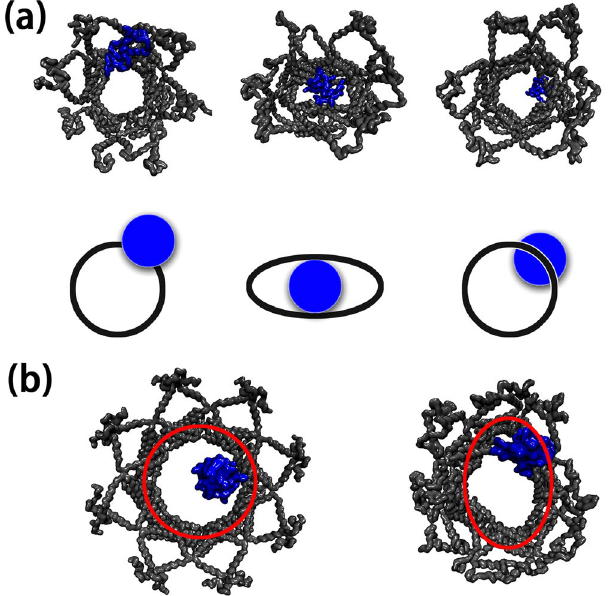
Figure 6. Snapshots for the simulated six-dimer Bax pores at ① (top left), ① (top middle) and ① (top right), and the schematic diagram highlighting the morphological changes of Bax oligomeric pores upon binding to cytochrome C (bottom), and ( b ) the initial and final structures of eight-dimer Bax pores. Color code: Bax oligomeric pores (black), cytochrome C